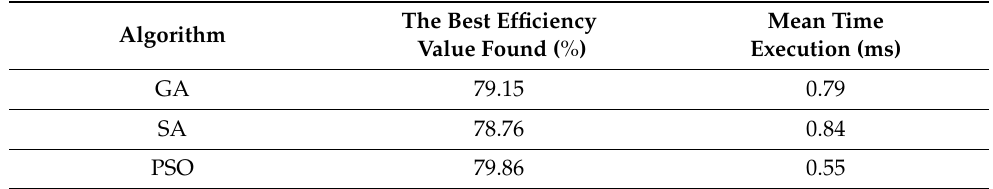
Table 3. Performance comparison of GA, SA and PSO algorithms.